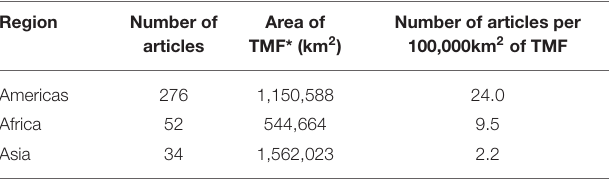
Region Number of Area of Number of articles per articles TMF* (km 2 ) 100,000km 2 of TMF Americas 276 1,150,588 24.0 9.5 Asia 34 1,562,023